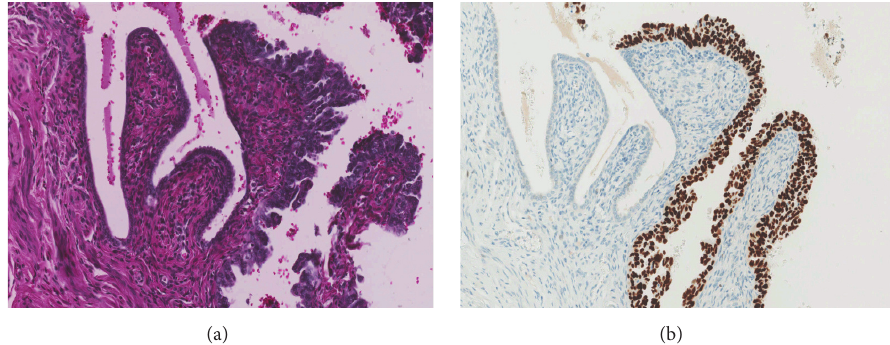
Figure 3: (a) Left fallopian tube: the serous tubal intraepithelial carcinoma (STIC) is noted in the tubal mucosa of the left fallopian tube (hematoxylin and eosin, 200x). (b) Left fallopian tube: the serous tubal intraepithelial carcinoma (STIC) displays strong nuclear p53 expression, in contrast to the adjacent tubal epithelia